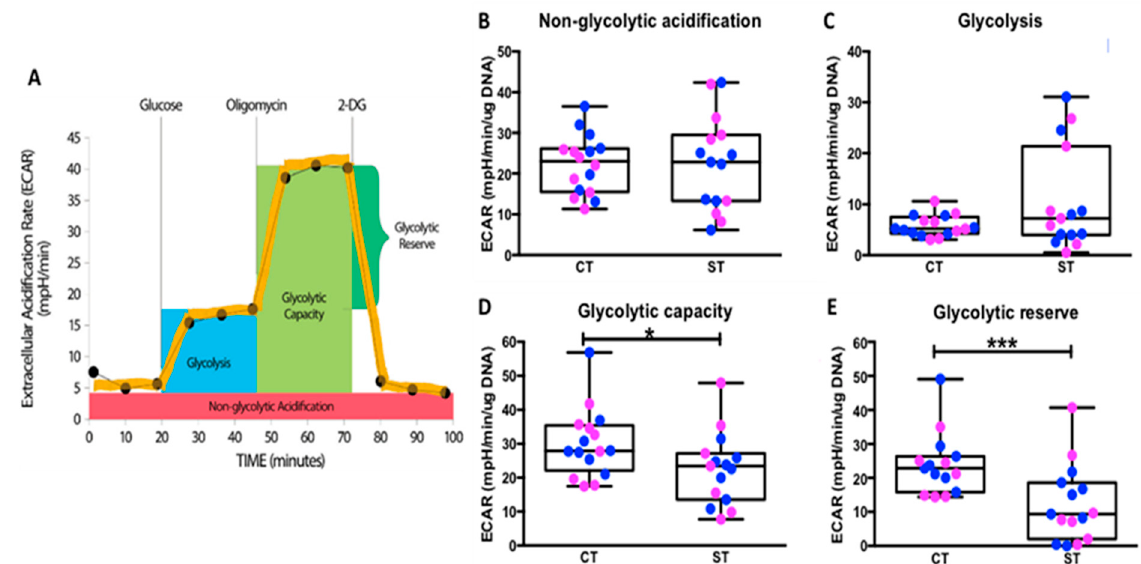
Figure 2. Glycolytic function of CT vs. ST analyzed using the glycolysis stress test. ( A ) Graphical representation of the glycolysis stress test, ( B ) non-glycolytic acidification, ( C ) glycolysis, ( D ) glycolytic capacity, and ( E ) glycolytic reserve. Male (blue, n = 8) and female (pink, n = 8) groups combined. Data presented as minimum, maximum, median, 25th and 75th quartiles boxes, and whisker plots. * p < 0.05, *** p < 0.001 (Wilcoxon signed-rank test). 2-DG: 2-deoxy-glucose, ECAR: extracellular acidification